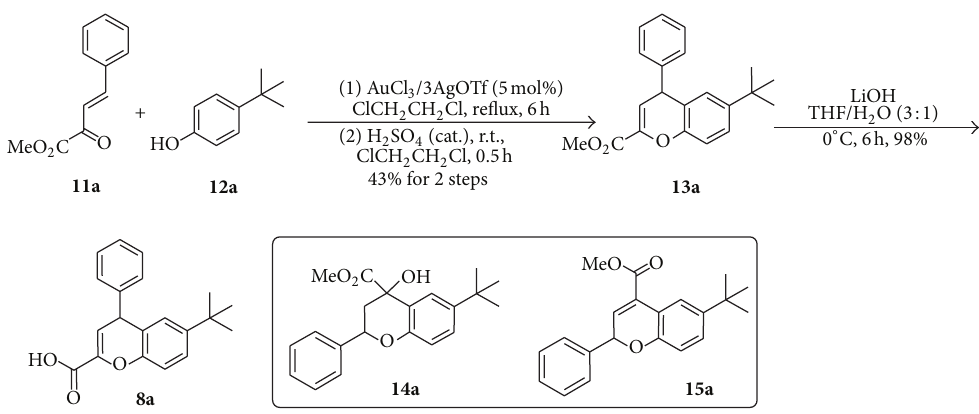
Scheme 2: Synthesis of 4 H -chromene-2-carboxylic acid 8a